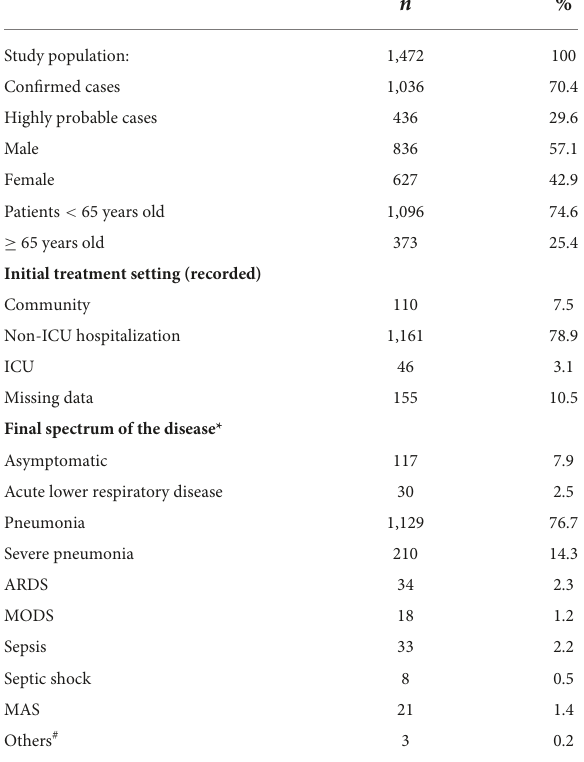
TABLE 1 Demographic characteristics, initial treatment setting, and disease